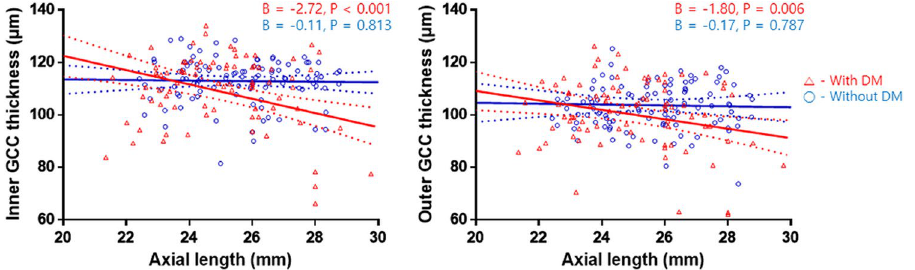
Figure 2. Scatterplots and results of linear regression analyses showing associations between parafoveal ganglion cell complex thickness and axial length in the non-diabetes (DM) groups (groups 1 and 3) and the DM groups (groups 2 and